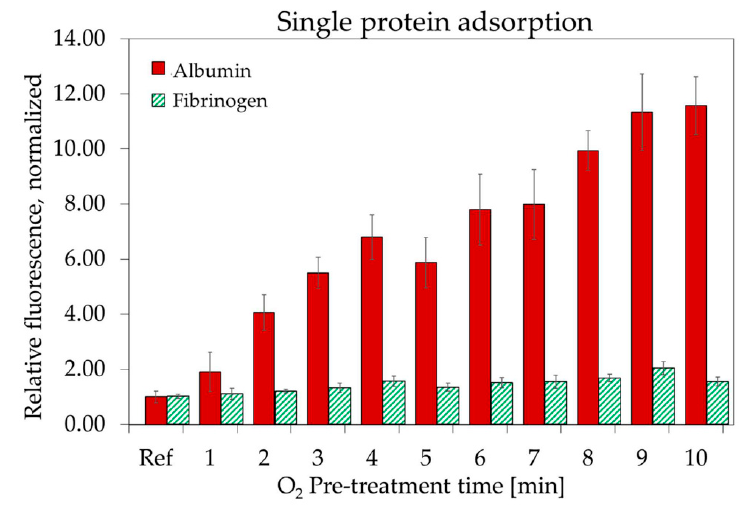
Figure 8. Single protein adsorption of albumin and fibrinogen on nanostructured Parylene-C surfaces in function of the O 2 plasma pre-treatment time. All measurements are normalized to the adsorption measured, for each protein, on untreated Parylene-C. The error bars represent the standard deviation between three different measurements.